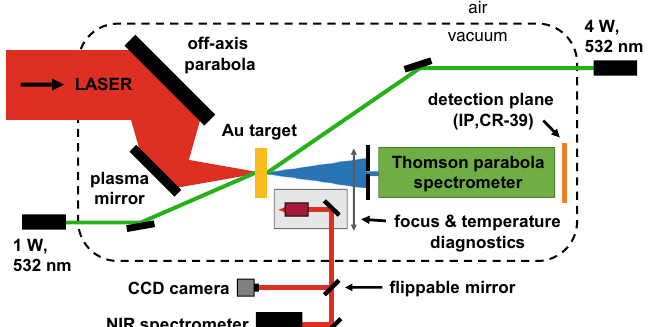
Figure 1. Experimental setup at the PHELIX